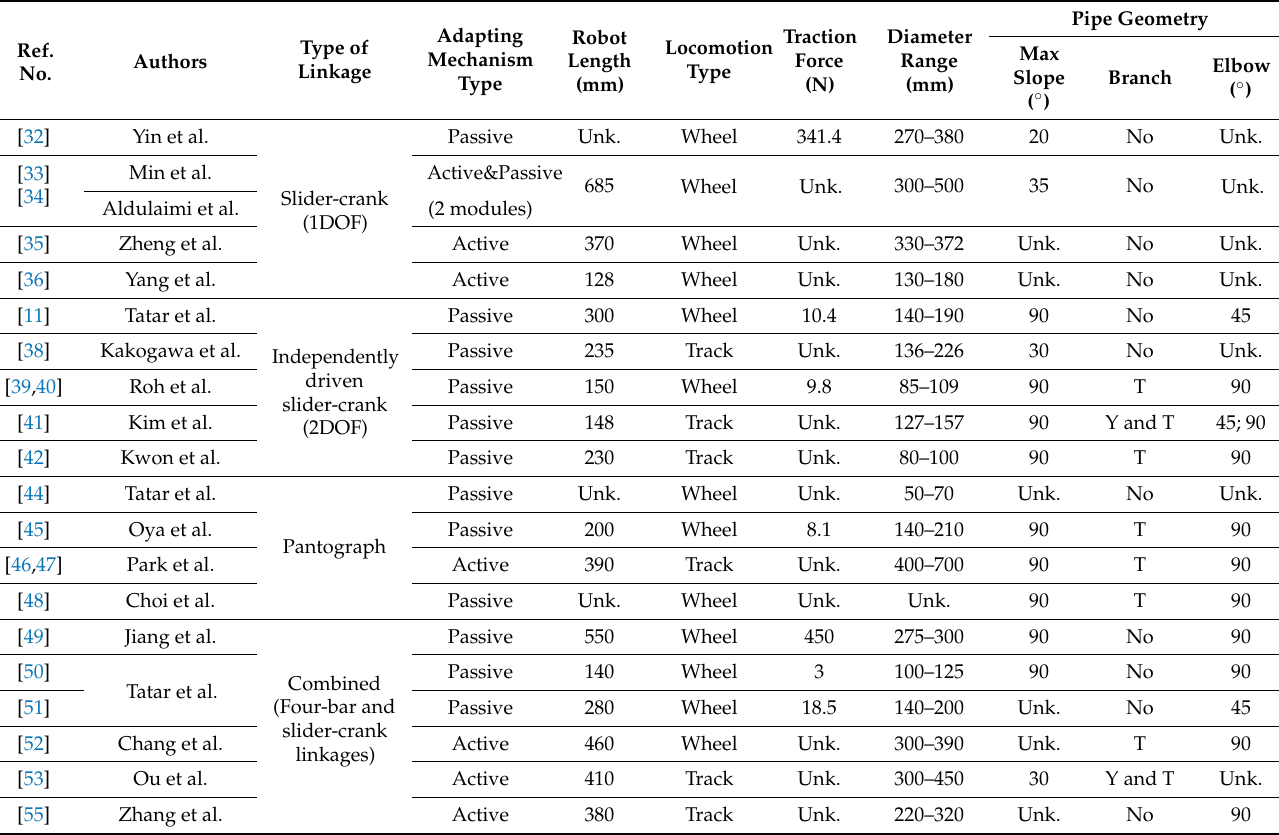
Table 1. Comparison between the adapting mechanisms of the robots presented in the